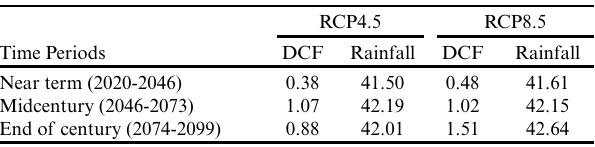
Table 2. Delta change factors (DCF) and the projected 95th percentile daily total rainfall (mm) based on the 19 GCMs for each time period, respective of climate change